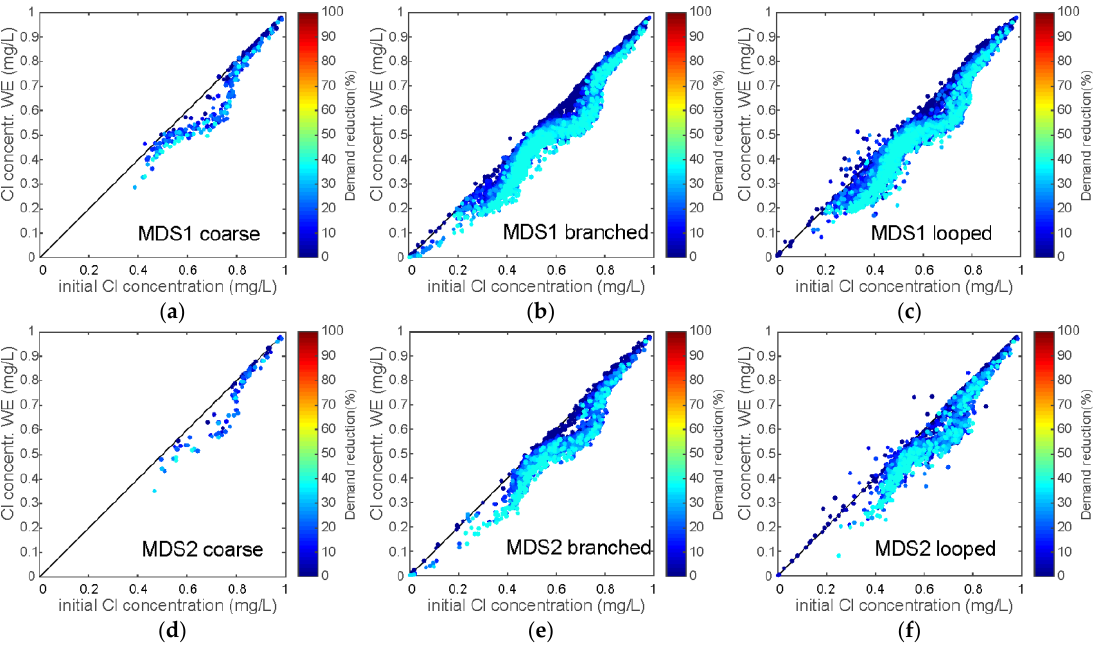
Figure 10. Investigation of chlorine concentrations and of the impact of the reduction scenarios WE in comparison with model refinements in the model MDS1 and MDS2 ( a ) coarse MDS1 model; ( b ) branched refinement of MDS1; ( c ) looped refinements of MDS1; ( d ) coarse MDS2 model ( e ) branched refinement of MDS2; ( f ) looped refinements of MDS2.